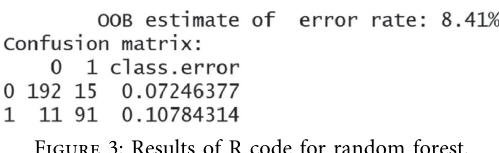
Figure 2: Results of ntree value traversal for random forest parameter search.